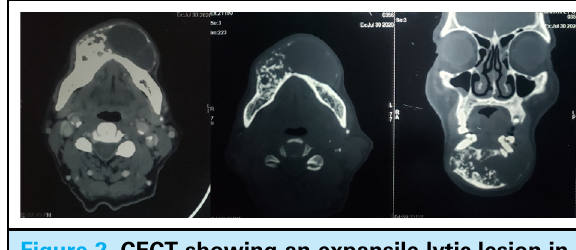
Figure 2. CECT showing an expansile lytic lesion in the mandible region, with enhancing areas noted adjacent to the remaining bone.